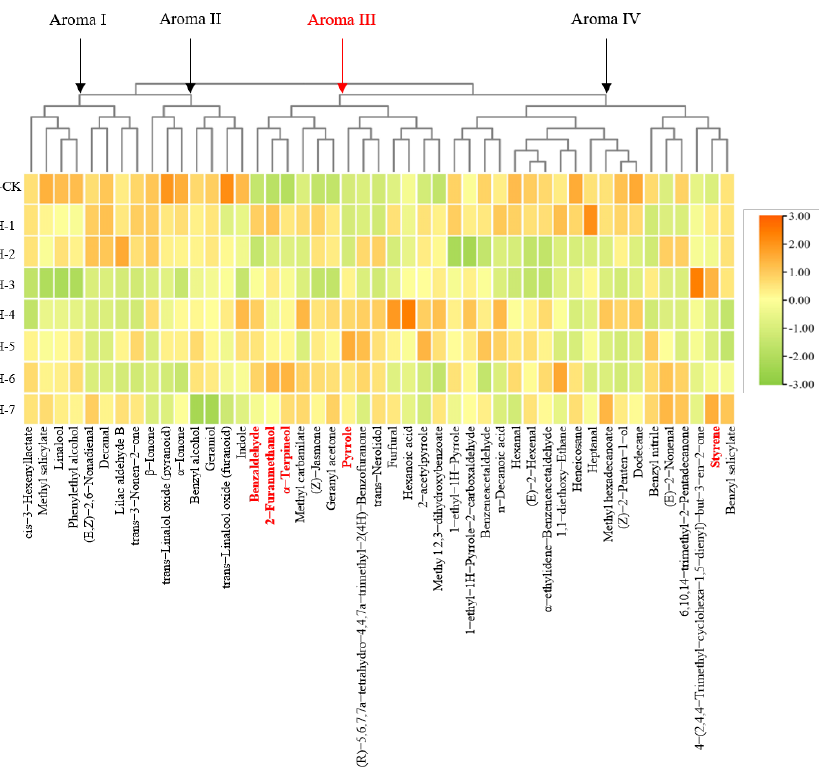
Figure 3. Cluster heat map of aroma compounds in aroma-enhanced Yunnan congou black teas baked at 90 °C (0 – 7 h).